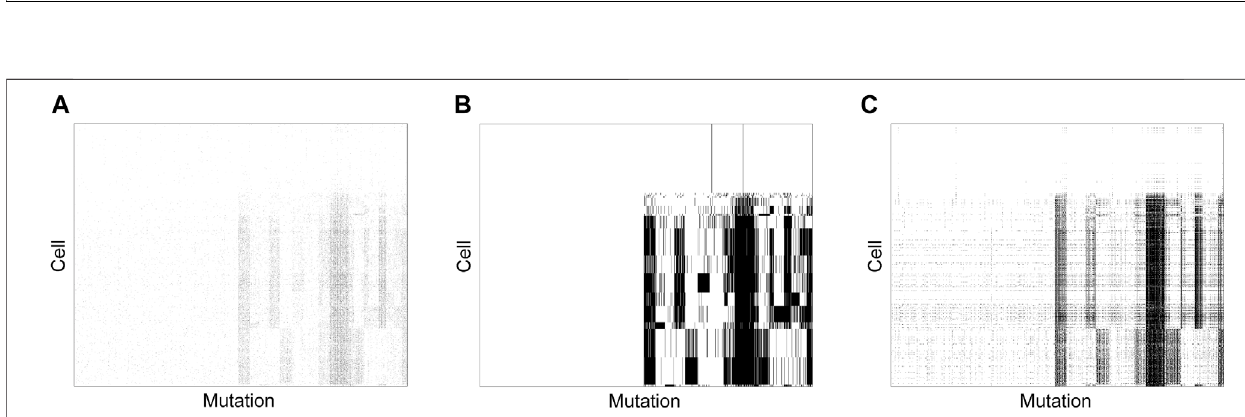
FIGURE9| Subclonesinferred fromhigh gradeserous ovariancancerdataset. SCClone identi fi es fi vesubclonesand estimatestheerrorratesas α =2.26%and β = 31.61%. (A) The observed 420 × 43 genotype matrix. (B) The recovered genotype matrix and inferred subclones. (C) Distribution of the cells among subclones. (D) Constructed lineage relationship of subclones by building the minimum spanning tree.